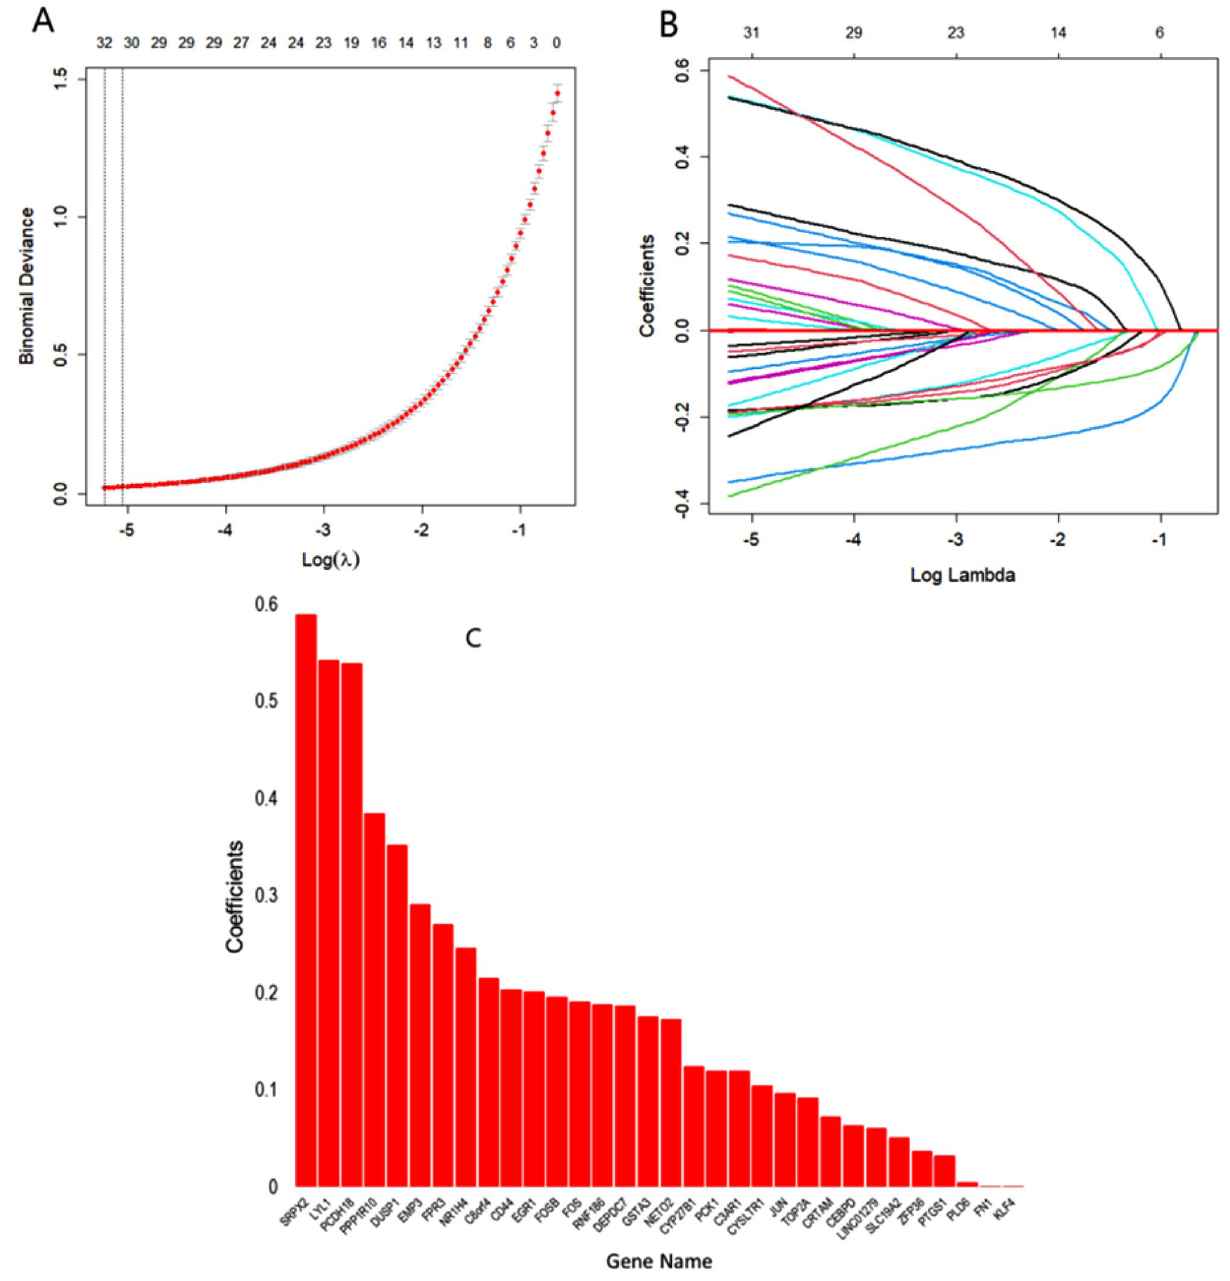
Figure 5. Discriminative gene selected using LASSO-based model by 10 CV: ( A ) A coefficient profile plot was generated against the log (λ) sequence. ( B ) 32 discriminative genes were selected for IgAN. ( C ) Contribution of 32 discriminative genes for IgAN